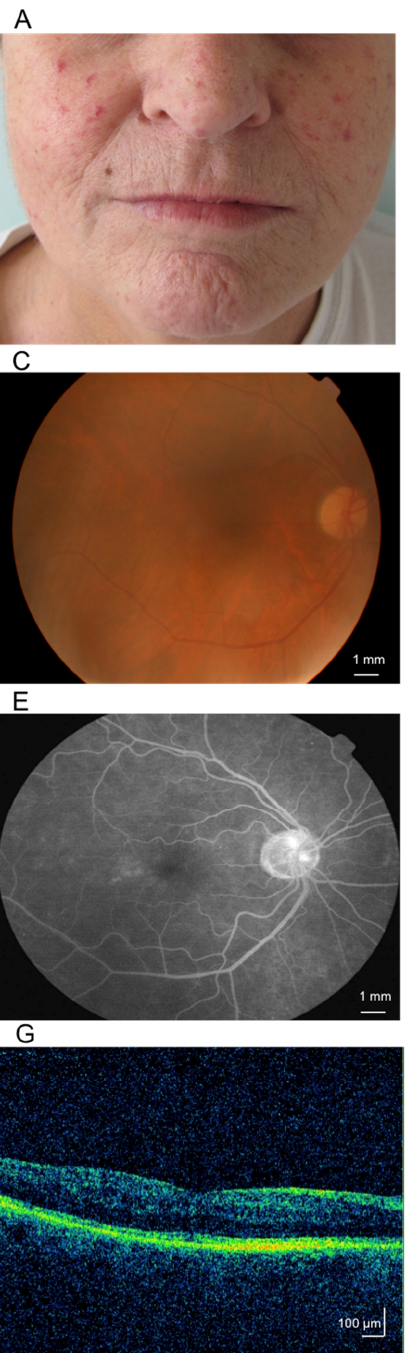
Figure 2. Patient 2, aged 64, diagnosed with systemic sclerosis (SSc) 10 years before the analysis. Photograph ( A ) shows a characteristic facial appearance for scleroderma: atrophy of the nasal wings, radial grooves around the mouth, thinning of the labial red and numerous telangiectasias. Nailfold videocapillaroscopy of late SSc pattern in the patient 2 ( B ) with characteristic disorganization of microvascular architecture; loss of capillaries with lowered density to two capillaries in linear mm; presence of dilated capillary ( > 20 µ m) with abnormal shape and ramification. The capillaries were marked with arrows. Images of right ( C , E , G ) and left ( D , F , H ) eye fundus of a patient 2, aged 64, diagnosedwithsystemicsclerosis10yearsbeforetheanalysis. Datapresentedasfluoresceinangiography (FA) versus optical coherence tomography (OCT). Fluorescein angiography in the recirculation phase showed multiple areas of delayed choroidal filling with hyperfluorescence corresponding to the areas of microaneurysms leakage ( E , F